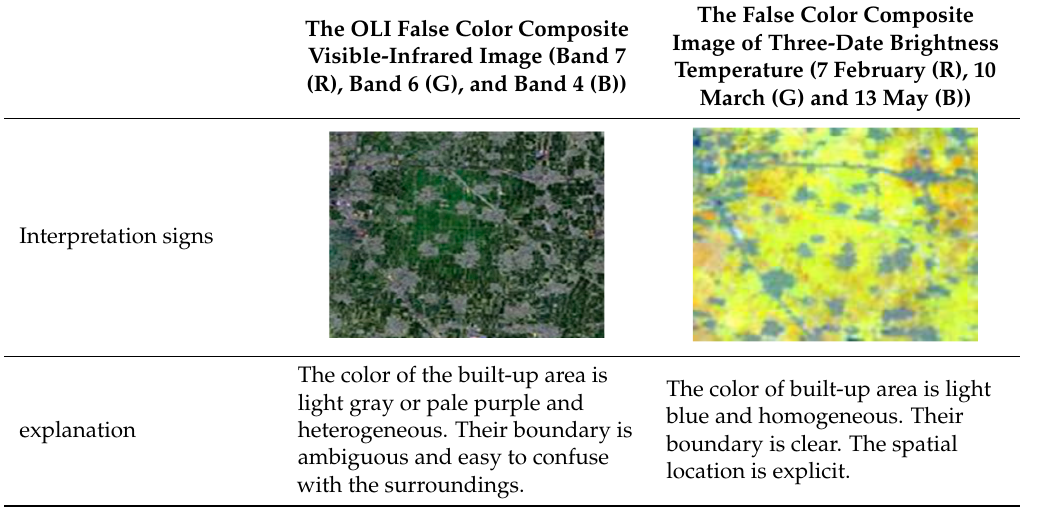
Table 2. The comparison of interpretation signs in the experimental study area.